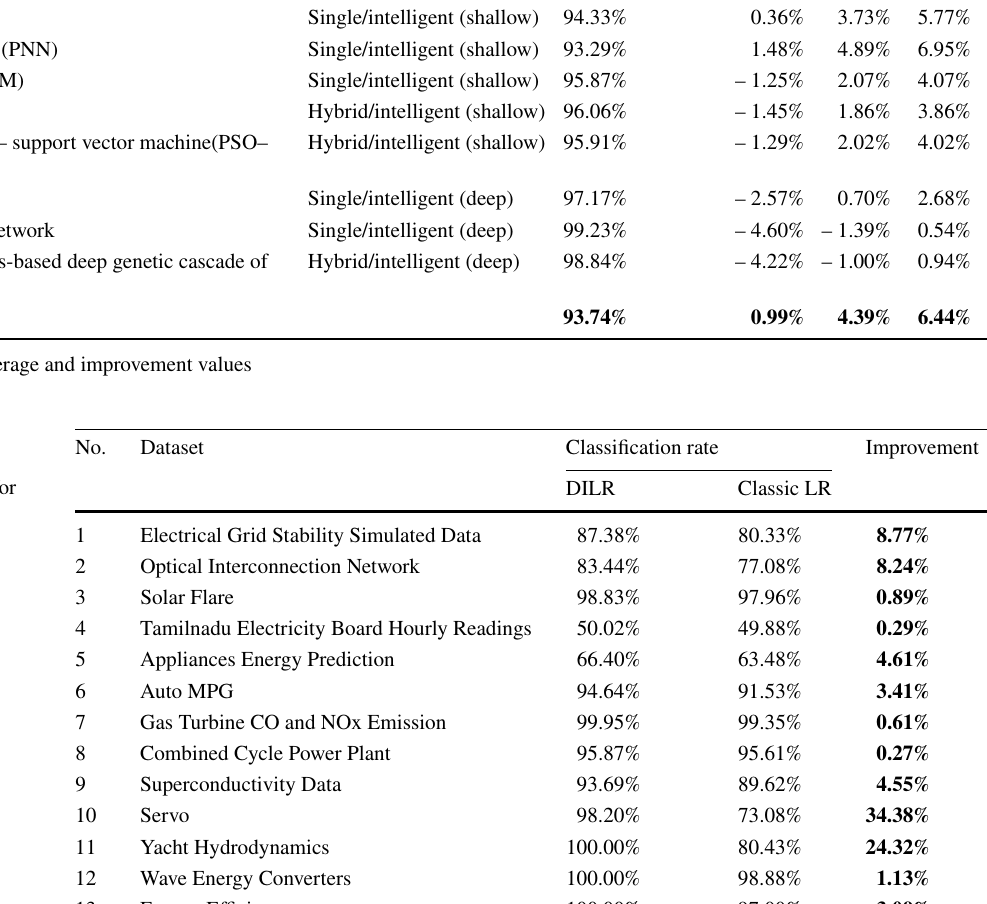
Bold values indicates the average and